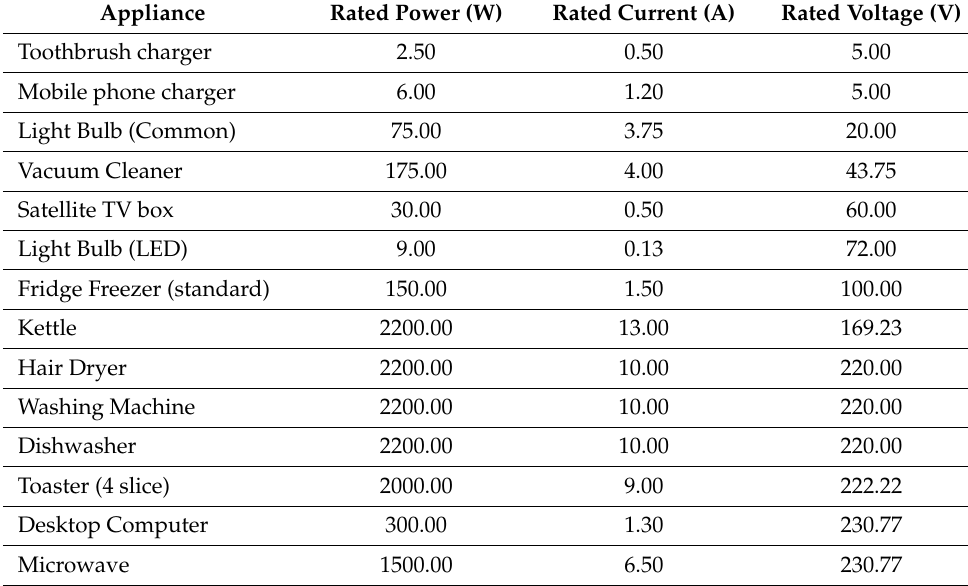
Table 4. Power consumption of household